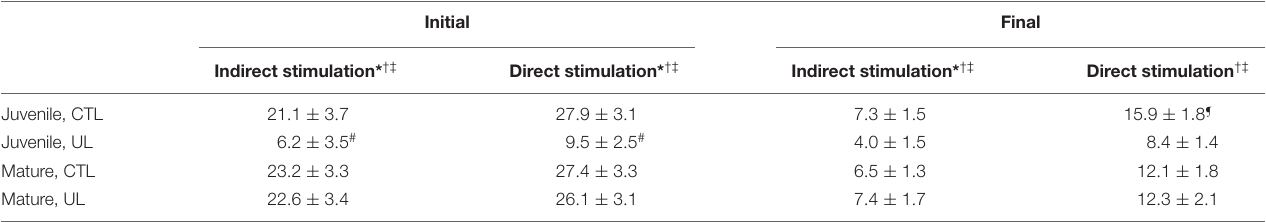
TABLE 3 | Effects of age (mature/juvenile) and treatment (control/unloaded) on specific tension at beginning (Initial) and conclusion (Final) of 5 min train of indirect (nerve) or direct (muscle) stimulation.